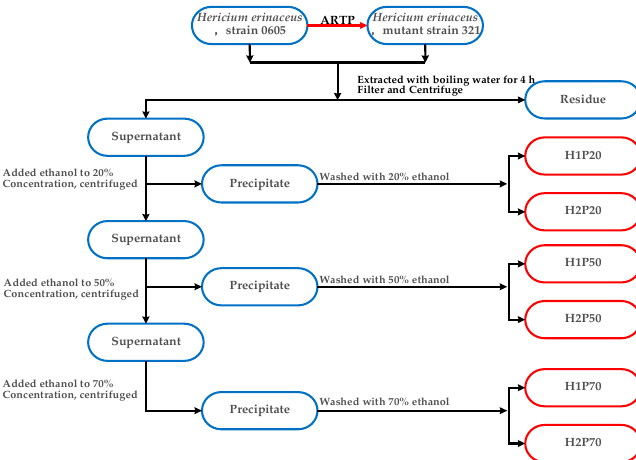
Figure 7. Stepwise extraction and isolation procedure of polysaccharides from fruiting bodies cultivated by two H. erinaceus strains.